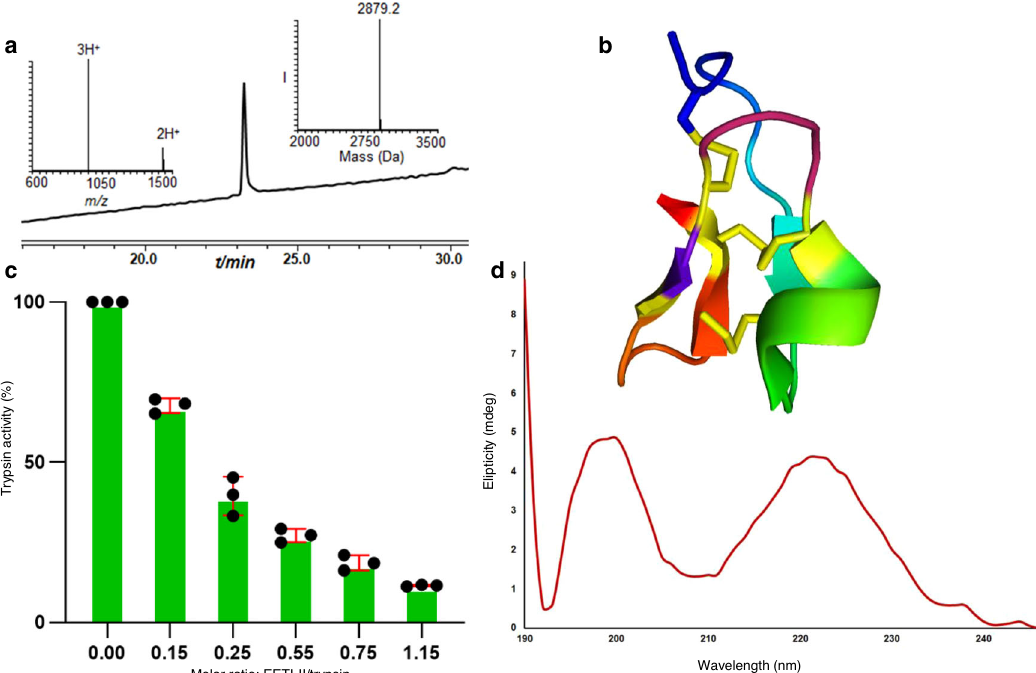
Fig. 7 Synthetic EETI-II characterization. a HPLC-ESI MS analyses of puri fi ed and folded EETI:, the main peak corresponds to EETI-II bearing three disul fi de bonds with the observed mass 2879.2± 0.1 Da, calcd. 2879.4 Da (average isotopes). b EETI-II structure (PDB). c Trypsin inhibition biological activity assay. Data are represented as mean ± SD, n = 3 biologically independent samples, error bars represent the SD. d CD spectrum of synthetic